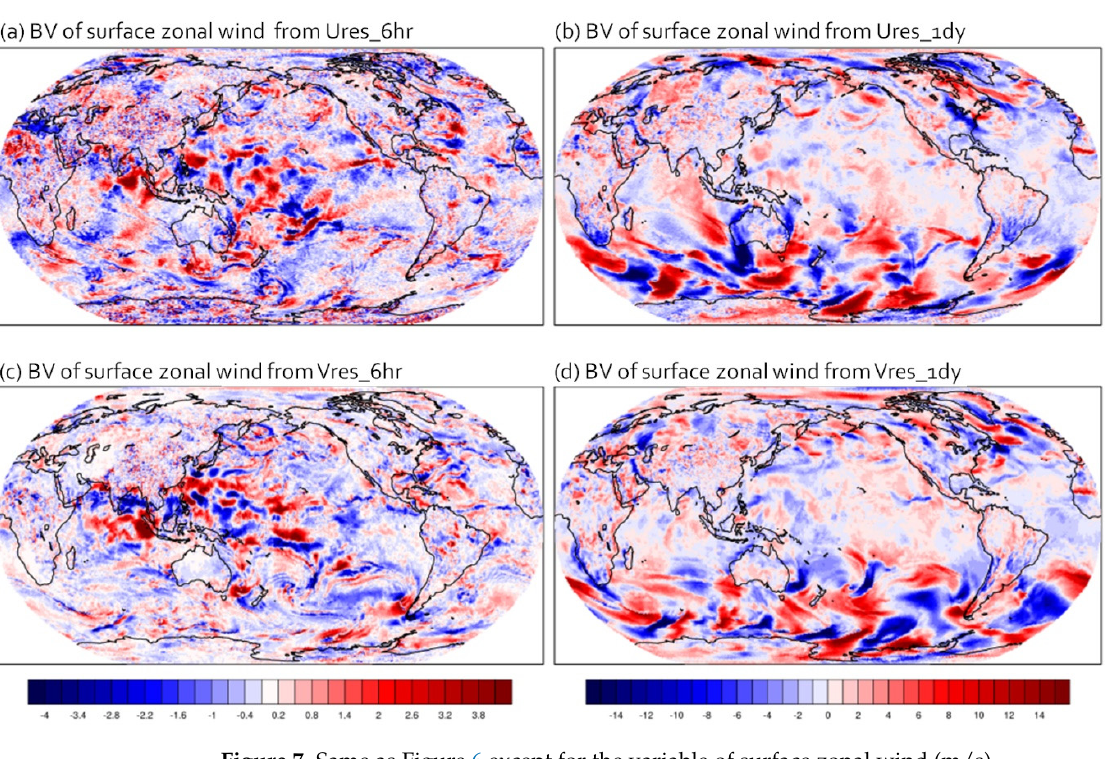
Figure 8. The same as Figure 6 except for the variable of surface meridional wind (m/s). For a quantitative analysis, we horizontally averaged the forecast errors weighted by the mesh area and then drew their vertical profiles (Figures 9 and 10). These errors were quantified by an RMS error and a bias between the ensemble mean of the forecast starting from bred vectors and the nature, as follows: